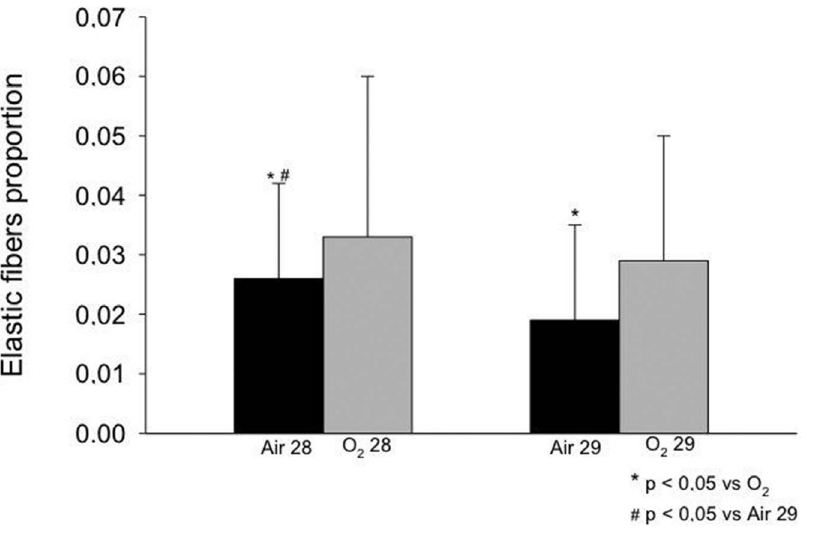
Figure 2. Elastic fibers proportion observed in the study groups. A higher proportion of elastic fibers were observed in both oxygen exposed groups compared with room air at the same gestational age (p , 0.05) and a higher proportion of elastic fibers was observed among more immature animals exposed to room air (p , 0.05).